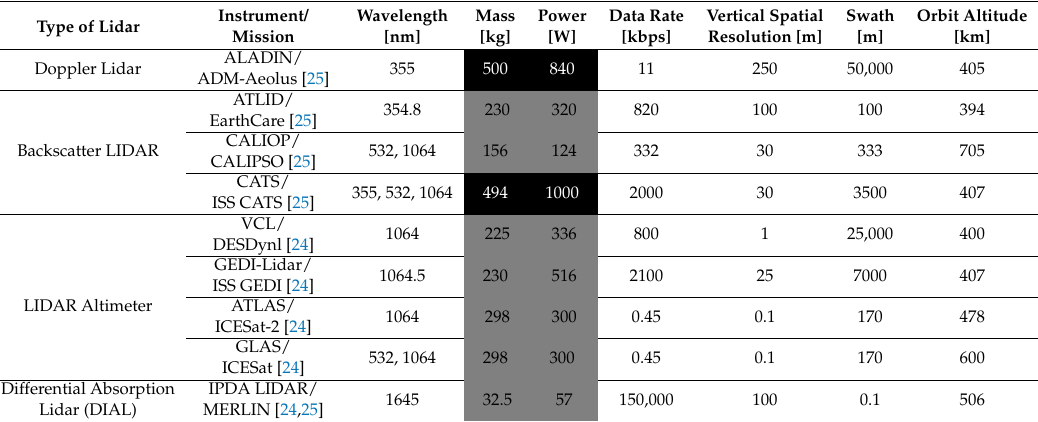
Table A14. Survey of the lidar